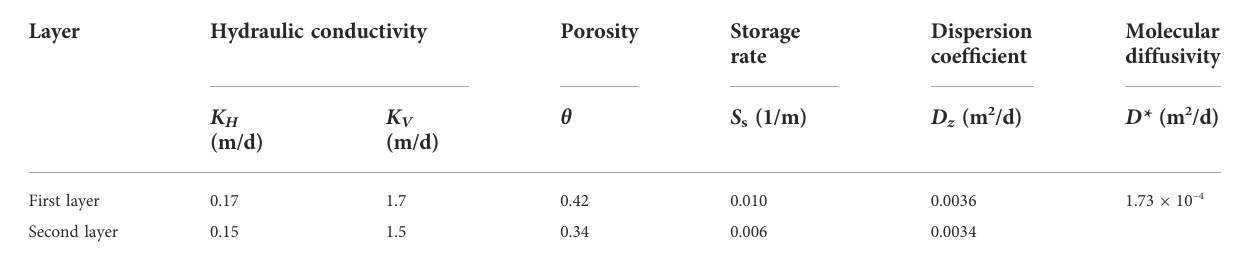
TABLE 1 The value of hydrogeological